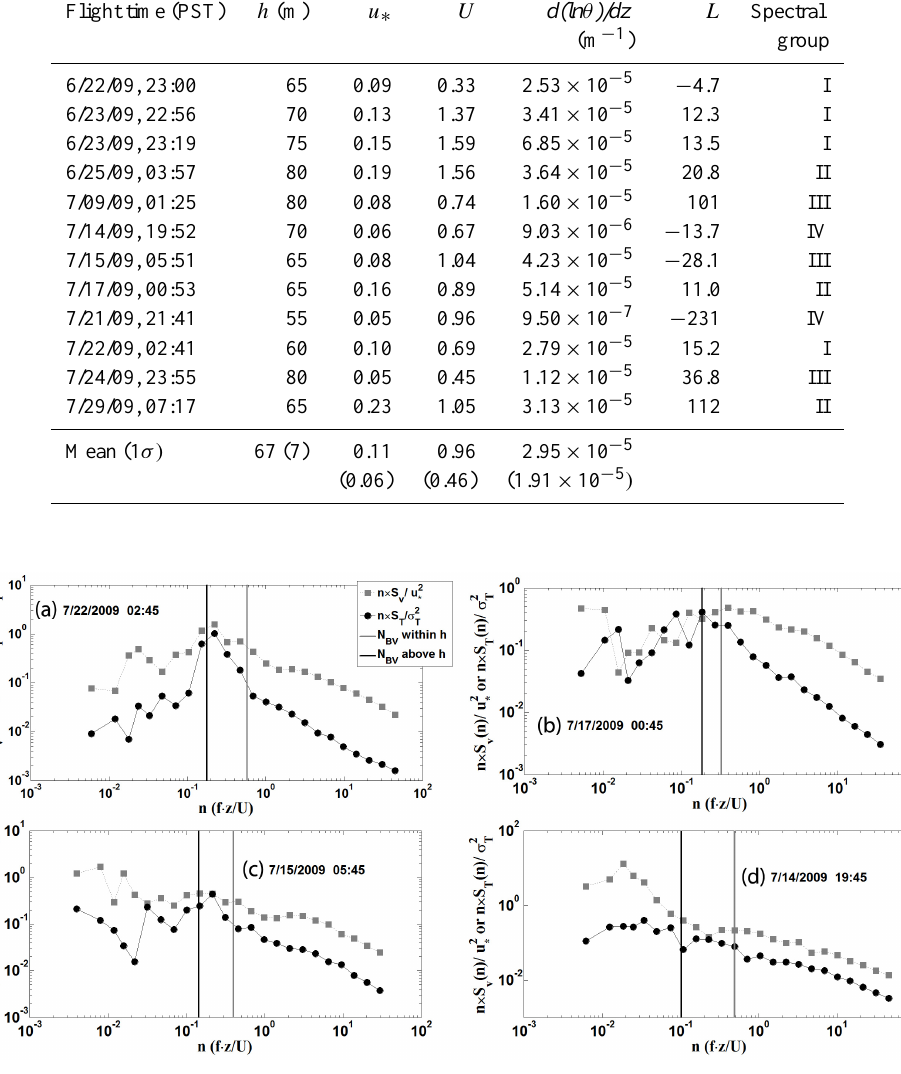
Fig. 9. Power spectra of crosswinds and temperature under NBL conditions during BEARPEX 2009. Black circles represent temperature power spectrum normalized by the variance of temperature and gray squares denote the power spectrum of the v -component wind normalized by friction velocity squared. Black vertical line denotes Brunt-V¨ais¨al¨a frequency ( N BV ) above the NBL and gray dashed line shows N BV within the NBL. All spectra obtained in 2009 show four different patterns (a) group I, (b) group II, (c) group III, and (d) group IV according to spectrum shape and the position of peak spectral frequency as explained in text. In general, spectral peak of the cross-stream winds tend to correspond to both the spectral peak of